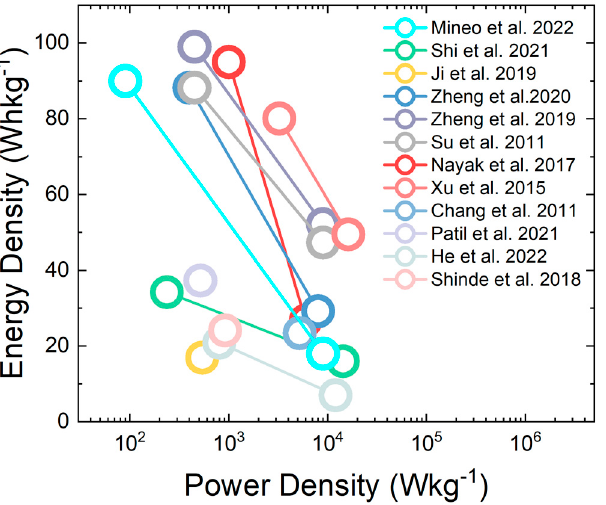
Figure 10. Ragone plot of the state-of-the-art research about WO 3 -based ASCs and SSCs. Reproduced by: Mineo et al., 2022 [19] Shi et al., 2021 [43], Ji et al., 2019 [46], Zheng et al., 2020 [50], Zheng et al., 2019 [51], Su et al., 2011 [53], Nayak et al., 2017 [56], Xu et al., 2015 [62], Chang et al., 2011 [74], Patil et al., 2021 [75], He et al., 2022 [76], Shinde et al., 2018 [77].